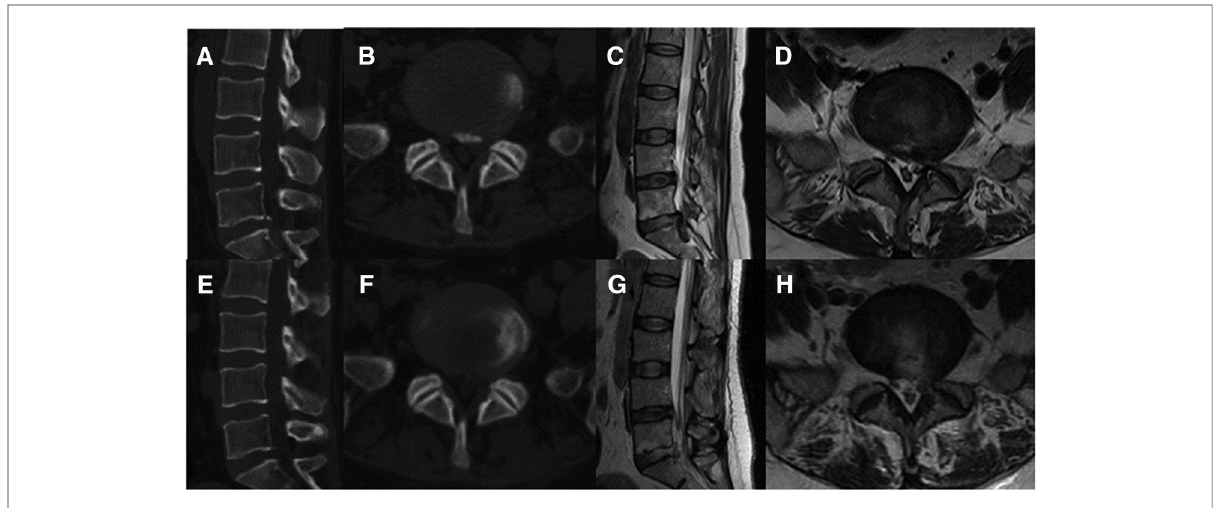
FIGURE 3 Pre- and post-operative CT and MRI ( A-H ). ( A-D ) Preoperative CT and MRI revealed lumbar disc herniation combined with calci fi cation. ( E-H ) Postoperative CT and MRI revealed that the calci fi ed intervertebral disc was removed and the compressed nerve root had been relieved by PEID.